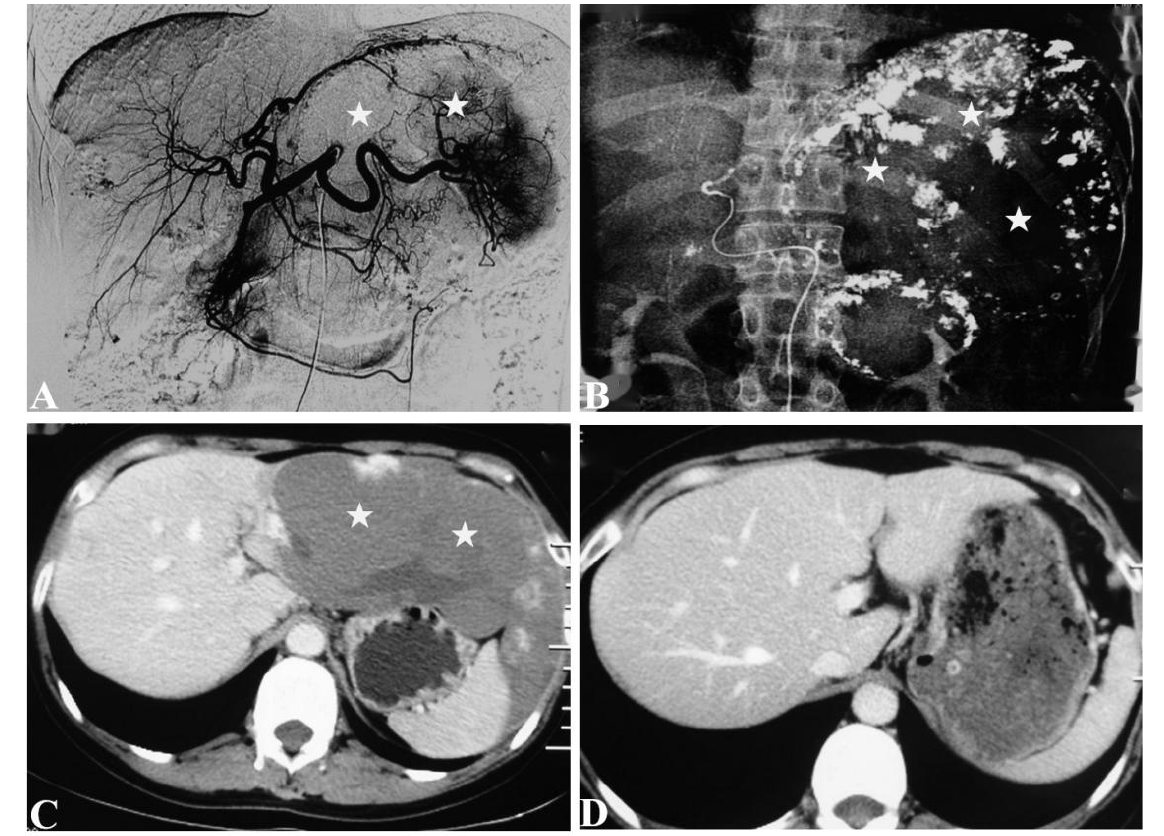
Figure 2. Representative case of complete disappearance of the tumor with TAE using a lipiodol–bleomycin emulsion (LBE). A 31-year-old woman presented with the left upper quadrant discomfort for 3 years. She was followed up for 6 years after TAE. ( A ). Digital subtraction angiography (DSA) of the hepatic artery showed a large hypervascular mass in the left lobe of the liver ( ★ ). ( B ). Upper abdominal radiogram obtained immediately post-TAE with LBE demonstrated the high dense lipiodol-emulsion retention in the lesion ( ★ ). ( C ). Axial contrast-enhanced computed tomography (CT) at portal venous phase obtained before TAE showed a huge lesion in the left lobes of the liver ( ★ ). ( D ). Axial contrast-enhanced CT at portal venous phase obtained at 5 years post-TAE showed complete response of the lesions. This patient had complete resolution of her abdominal symptoms at 6 months after TAE and the hemangioma reduction was 100% at the last follow-up, without recurrence.